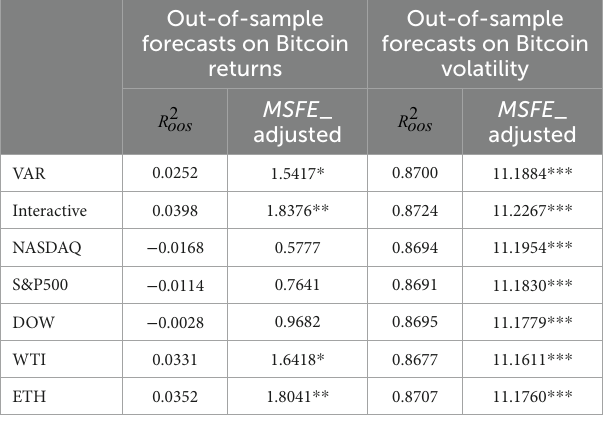
TABLE 12 Robustness checks for portfolio performance measures. Panel A: Portfolio performance measures: the perspective of utility